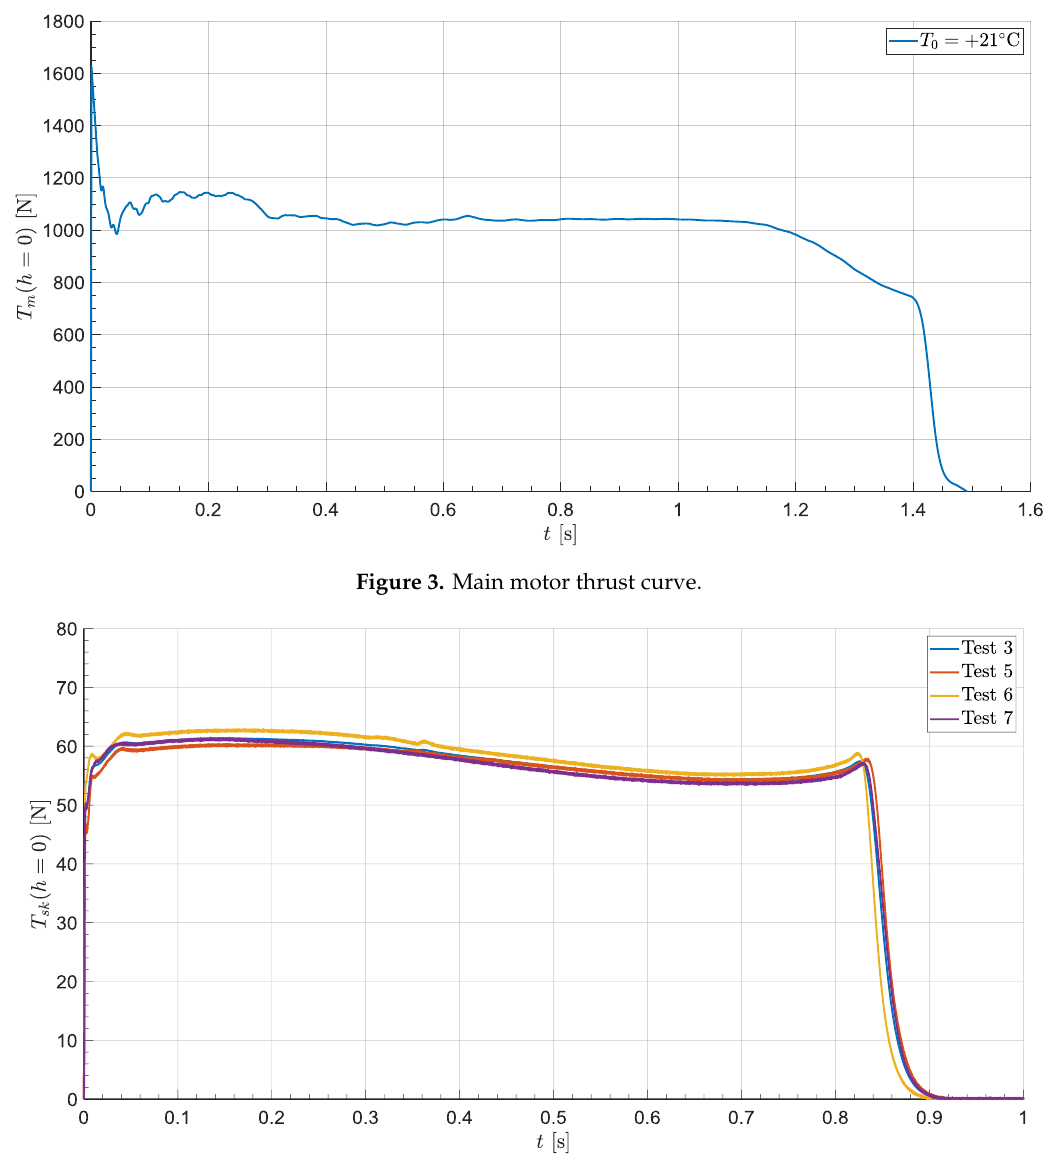
Figure 4. Lateral thruster thrust curves.